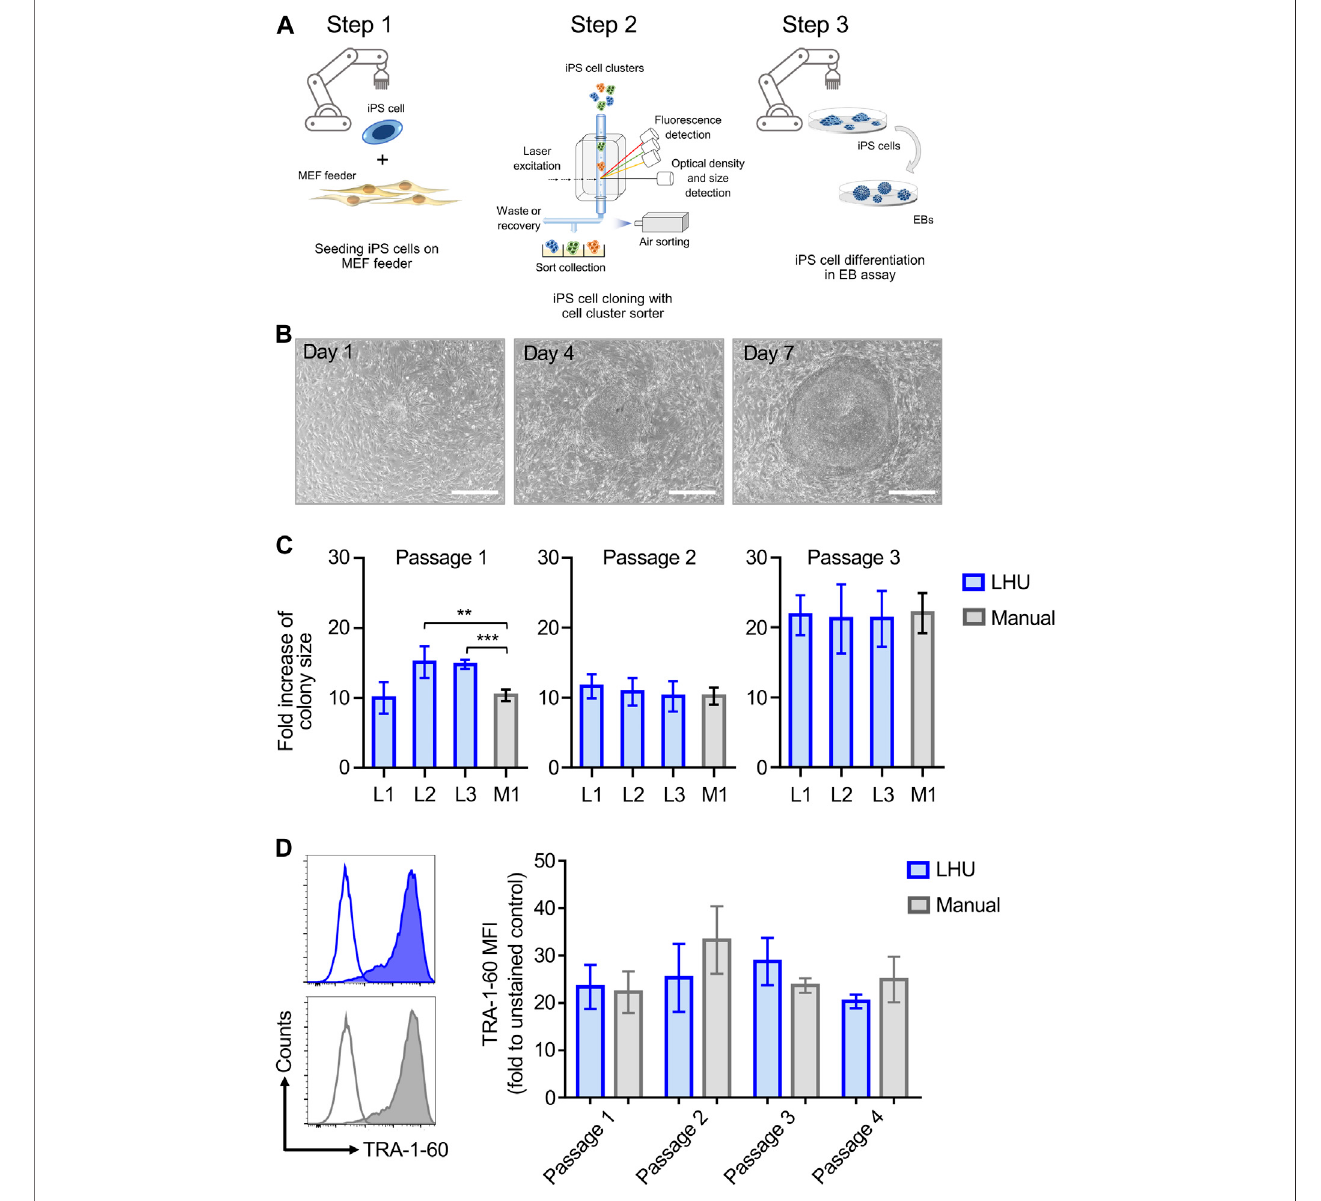
FIGURE 1 | Automated iPS cell culture on MEF feeder. (A) Schematic representation of iPS cell culture on MEF feeder, iPS cell cloning with cell cluster sorter and iPS cell differentiation through formation of EB (Steps 1, 2 and 3, respectively). (B) Representative phase contrast microscopy images of the same iPS cell colony from automatedculture at day 1,4and 7afterpassaging.Scale bar:650 µm. (C) Thegrowth ofiPS cellcolonies cultured manually (M1,grey bars) orbytheLHU (L1-L3,blue bars) was monitored for three passages and each passage was cultured for 7 days. Bars (±SD) show the averaged fold increase in colony size of four selected coloniesin each experiment ( n =4). Colony sizewasdetermined withacustom-made python algorithm (see Supplementary Material S1 and Methods). Fold increase of colony size was calculated as the ratio of colony size on day 7 relative to day 1. ** p < 0.01, *** p < 0.001. (D) Left: Representative histogram plots of TRA-1-60 expressiononiPScellsculturedbyautomatedhandling(LHU;blue)andmanualhandling(Manual;gray).Emptyplotsshowunstainedcells, fi lledplotsshowstainedcells. Right:TRA-1-60mean fl uorescenceintensity(MFI)valuesobtainedforiPScellsculturedbyautomatedhanding(LHU,blue, n =3)andmanualhandling(Manual,gray,n= 3) over three consecutive